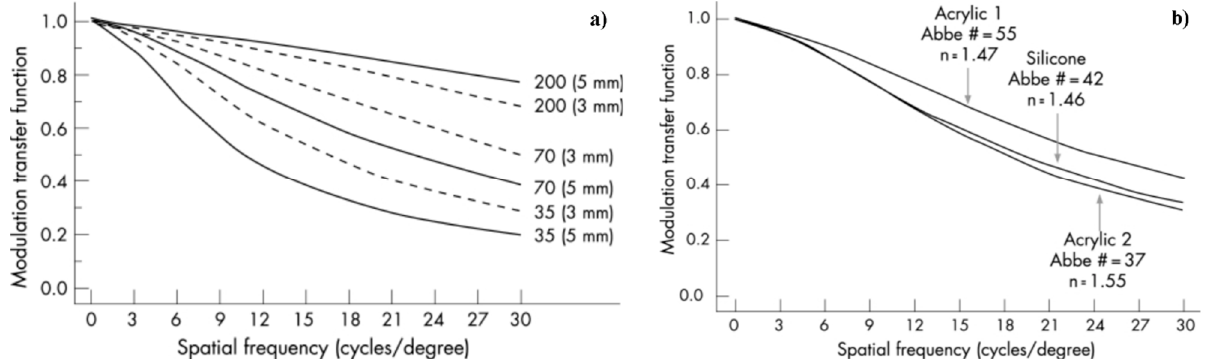
Figure 3. ( a ) Photopic polychromatic MTFs for an IOL with refractive index of 1.46 and Abbe numbers of 35, 70, and 200. Results for 3 mm and 5 mm pupil diameters are shown. ( b ) The MTFs trend for a silicone and two different acrylic IOLs. Reproduced from British Journal of Ophthalmology, Zhao, H.; Mainster, M.A., 91, 1225–1229, copyright 2007 with permission from BMJ Publishing Group Ltd. [20].